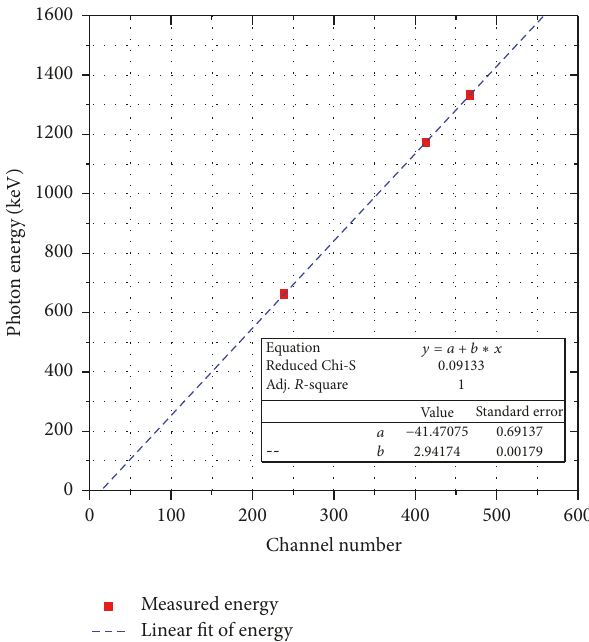
Figure 4: The calibration energy curves (measured and fit) using standard point sources ( 60 Co and 137 Cs) with NaI(Tl) well-type